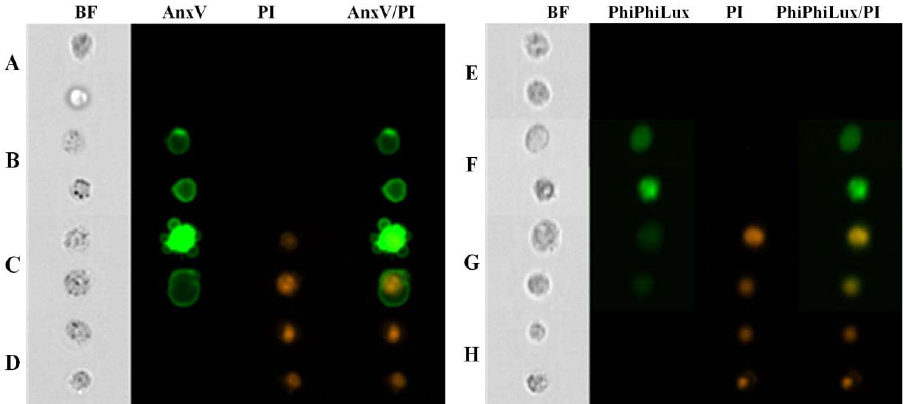
Figure 3. Results of FlowSight analysis of HL60 cells treated with t-resveratrol in IC 50